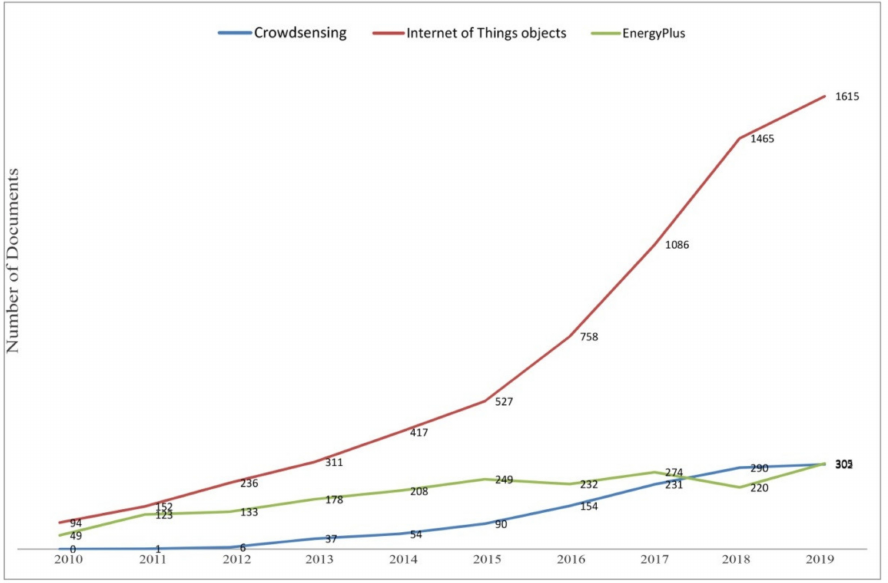
Figure 3. Trends of studies according to Scopus in the last decade. Queries: “Crowdsensing”, “Internet of things objects”,